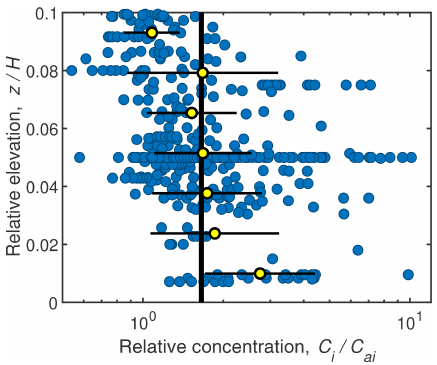
Figure 13. Grain-size-specific concentration, C i , from the lowest 10% of the flow (i.e., below the reference level z = 0 . 1 H ) rela- tive to the concentration at the reference level, C ai , as a function of depth above the bed, z , relative to the flow depth, H . Yellow filled symbols are the geometric mean; the error bars indicate the geomet- ric standard deviation within each elevation bin, and the black line is the geometric mean of all data representing C i = 1 . 66 C ai